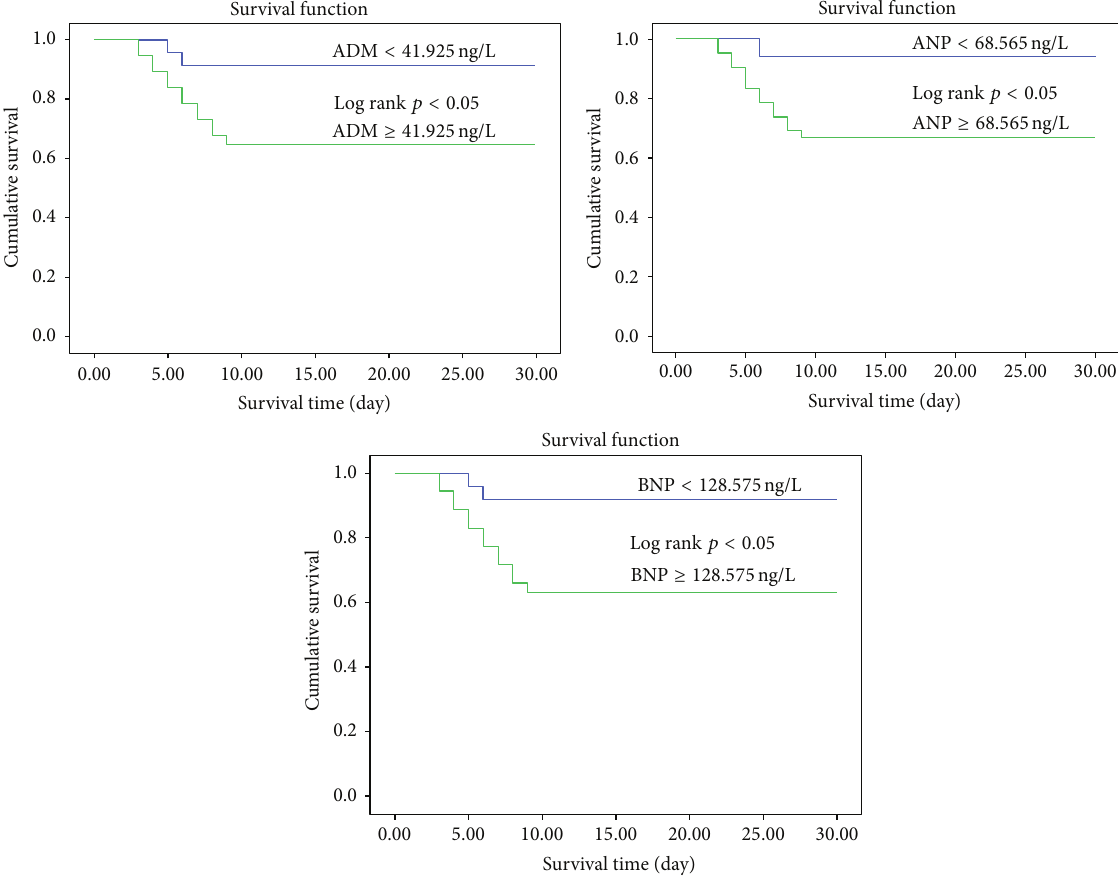
Figure 4: Kaplan-Meier curves for 69 uroseptic patients subdivided into two groups according to the cutoff values of ADM, ANP, and BNP in